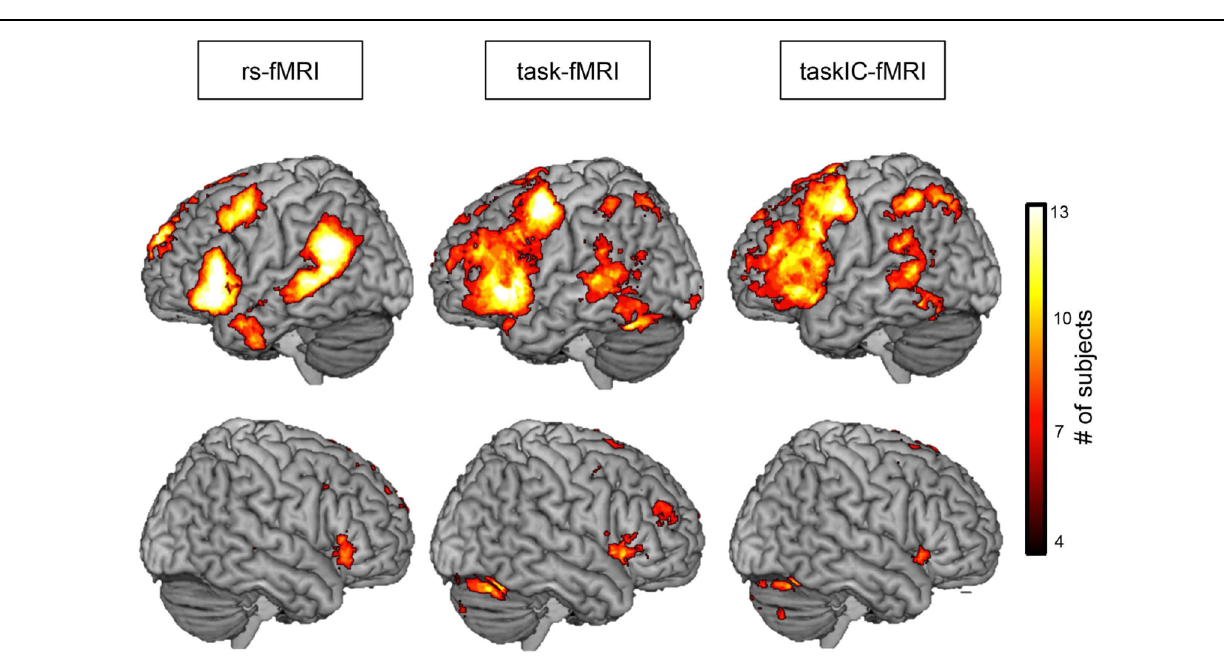
FIGURE 4 | Probabilistic overlap map across subjects for rs-fMRI, task-fMRI and taskIC-fMRI. Colors represent the number of subjects with significant activations at each voxel. Images were thresholded between 4 and 13 subjects for better